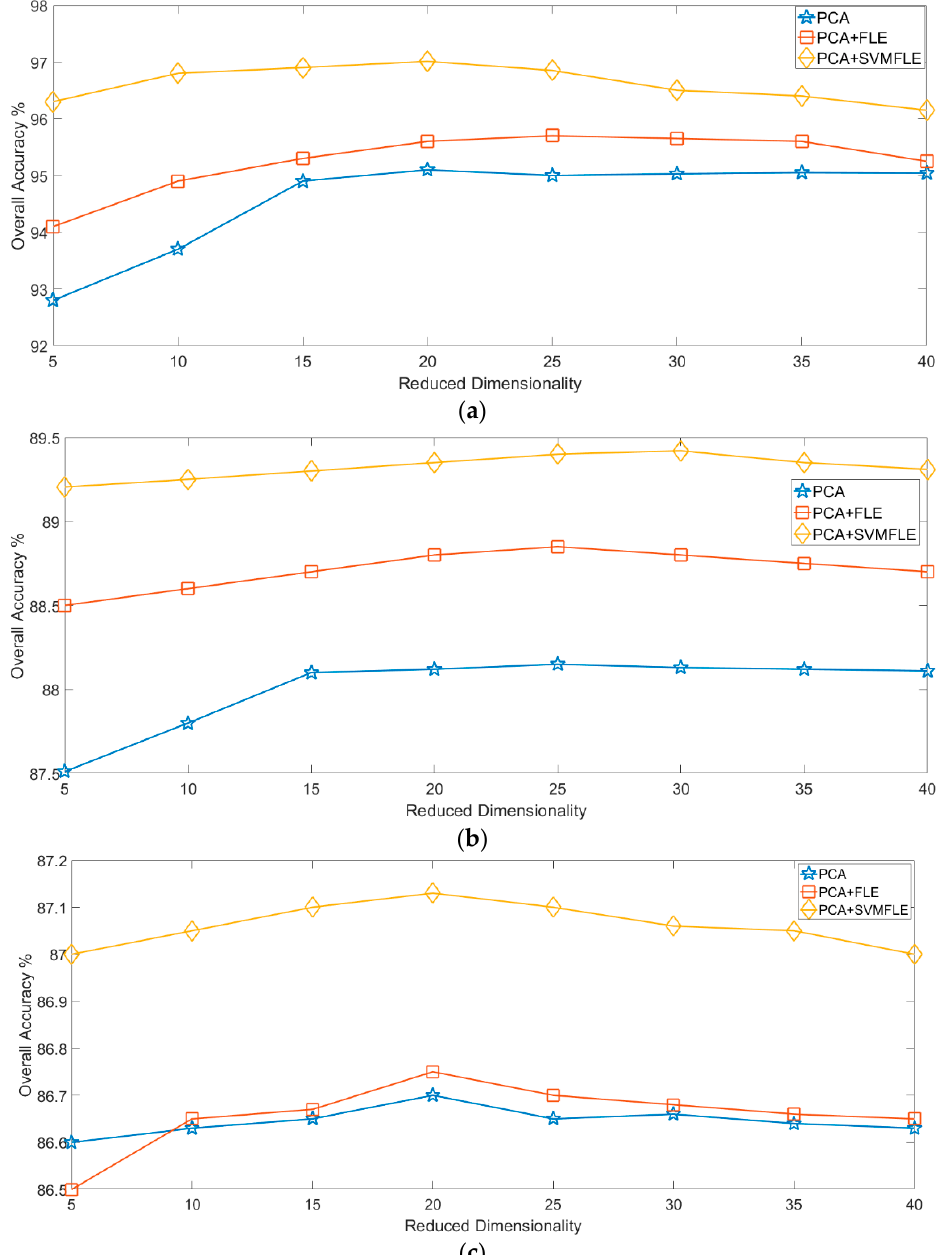
Figure 13. The reduced dimension versus the classification accuracy by GAN classifier on three datasets: ( a ) Salinas; ( b ) Pavia University; ( c ) IPS.